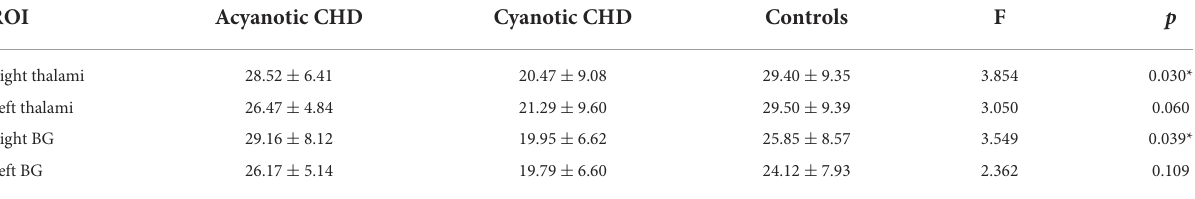
TABLE 4 Comparison of regional CBF by ASL between CHD subgroups and controls (mL/100 g/min). ROI Acyanotic CHD Cyanotic CHD Controls F p